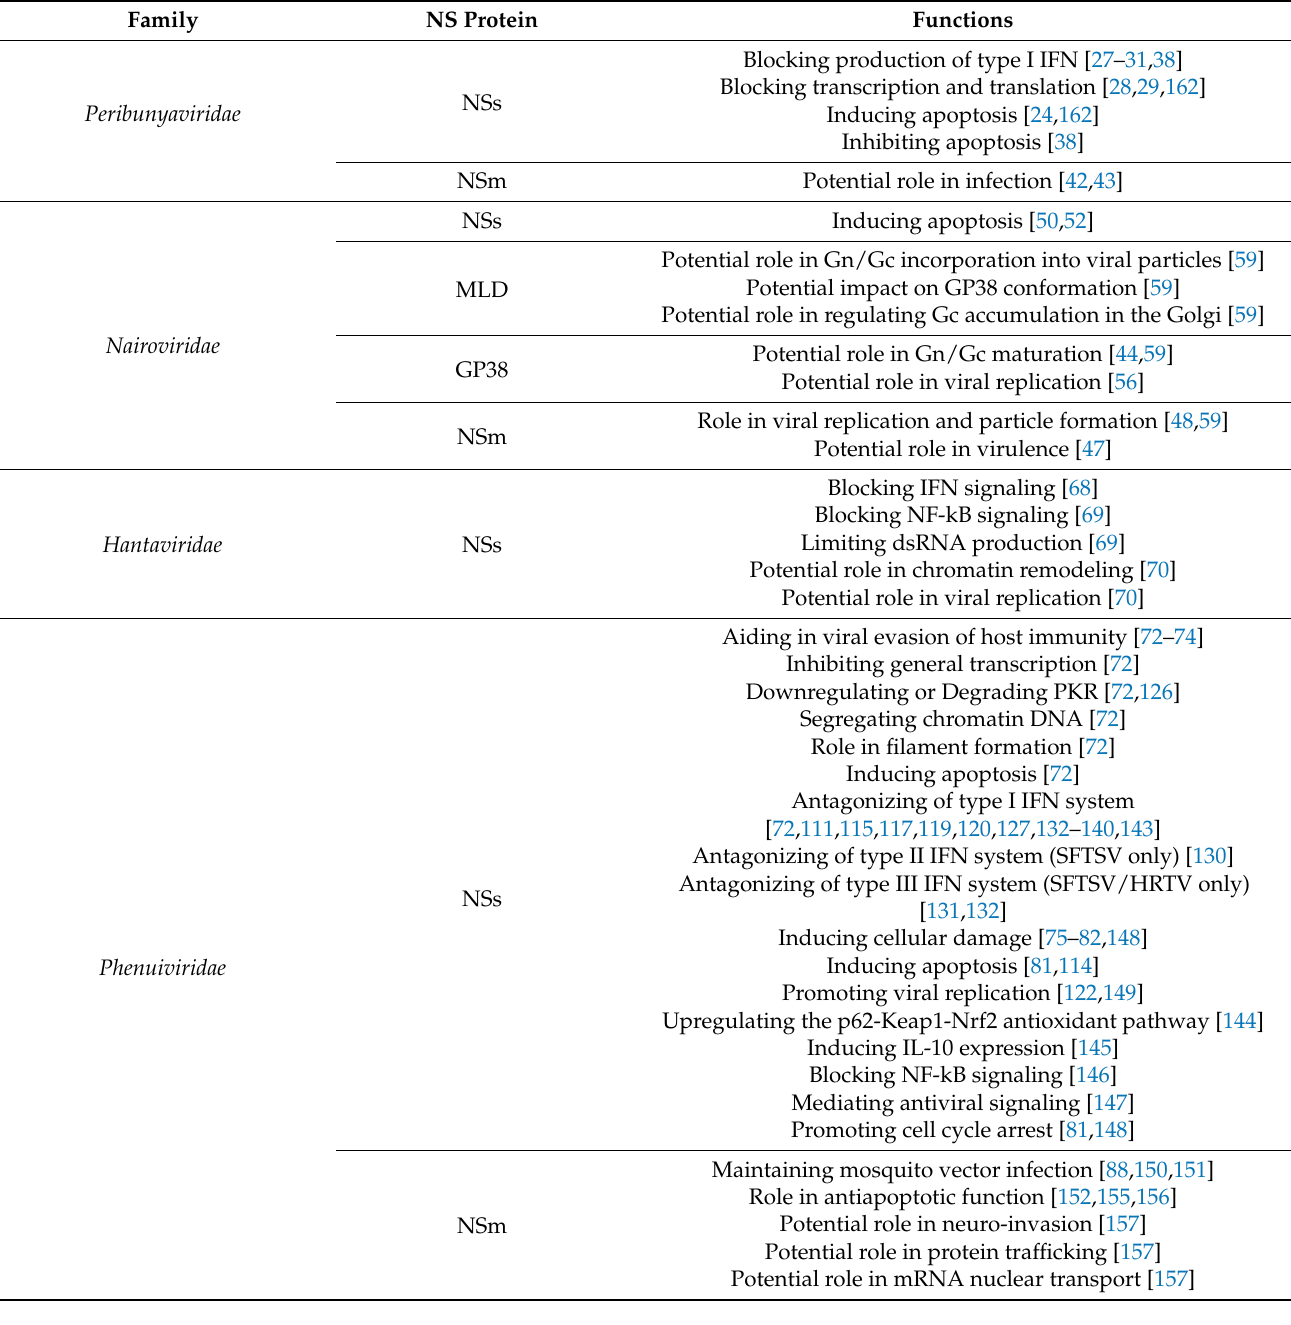
Table 2. Overview of NS Protein Functions. Overview of the various functions of non-structural (NS) proteins discussed for human pathogen-containing Bunyavirales families: Peribunyaviridae , Nairoviridiae , Hantaviridae , and Phenuiviridae